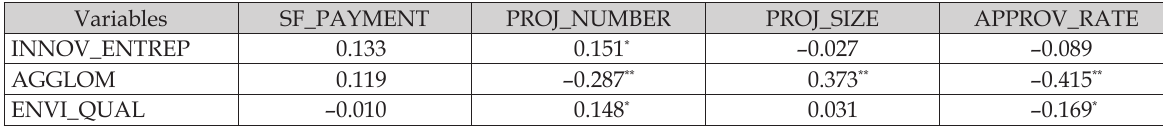
Table 4. Pearson correlation coefficients.